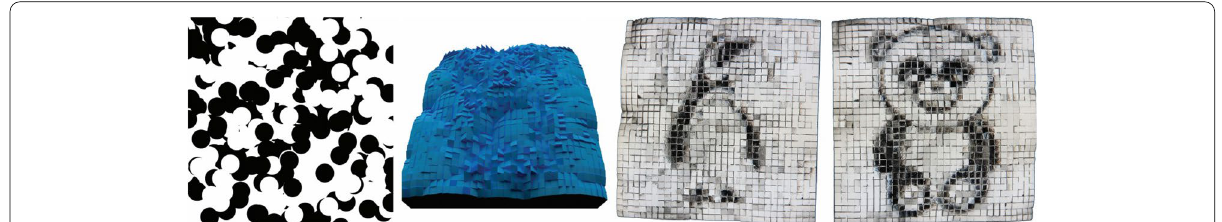
Fig. 23 From left to right: source image, lens, and the result images when the lens is placed over the source image in different orientations